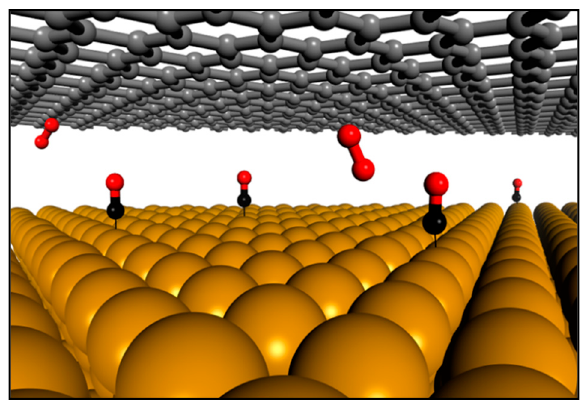
Figure 8. Sketch of graphene-protected chemical reactions catalyzed by a metal surface.